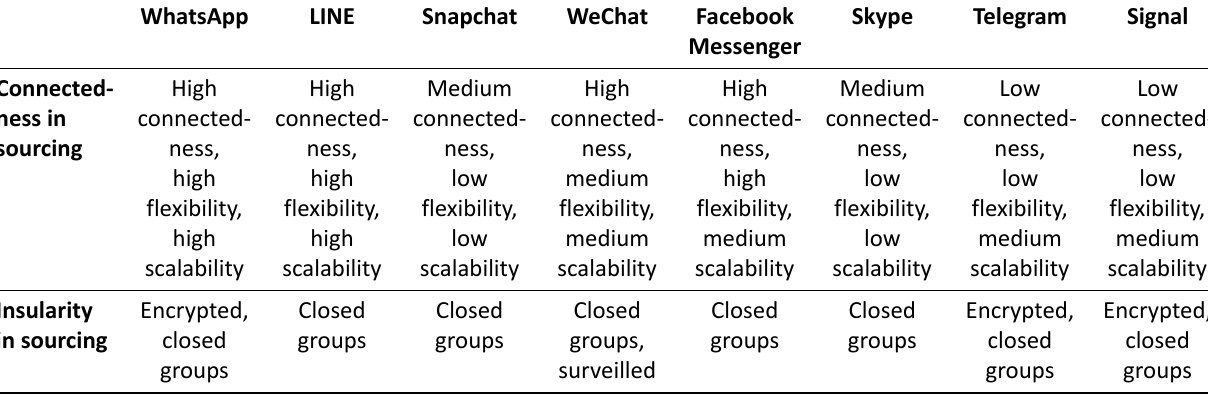
Table 1. Journalistic sourcing on chat